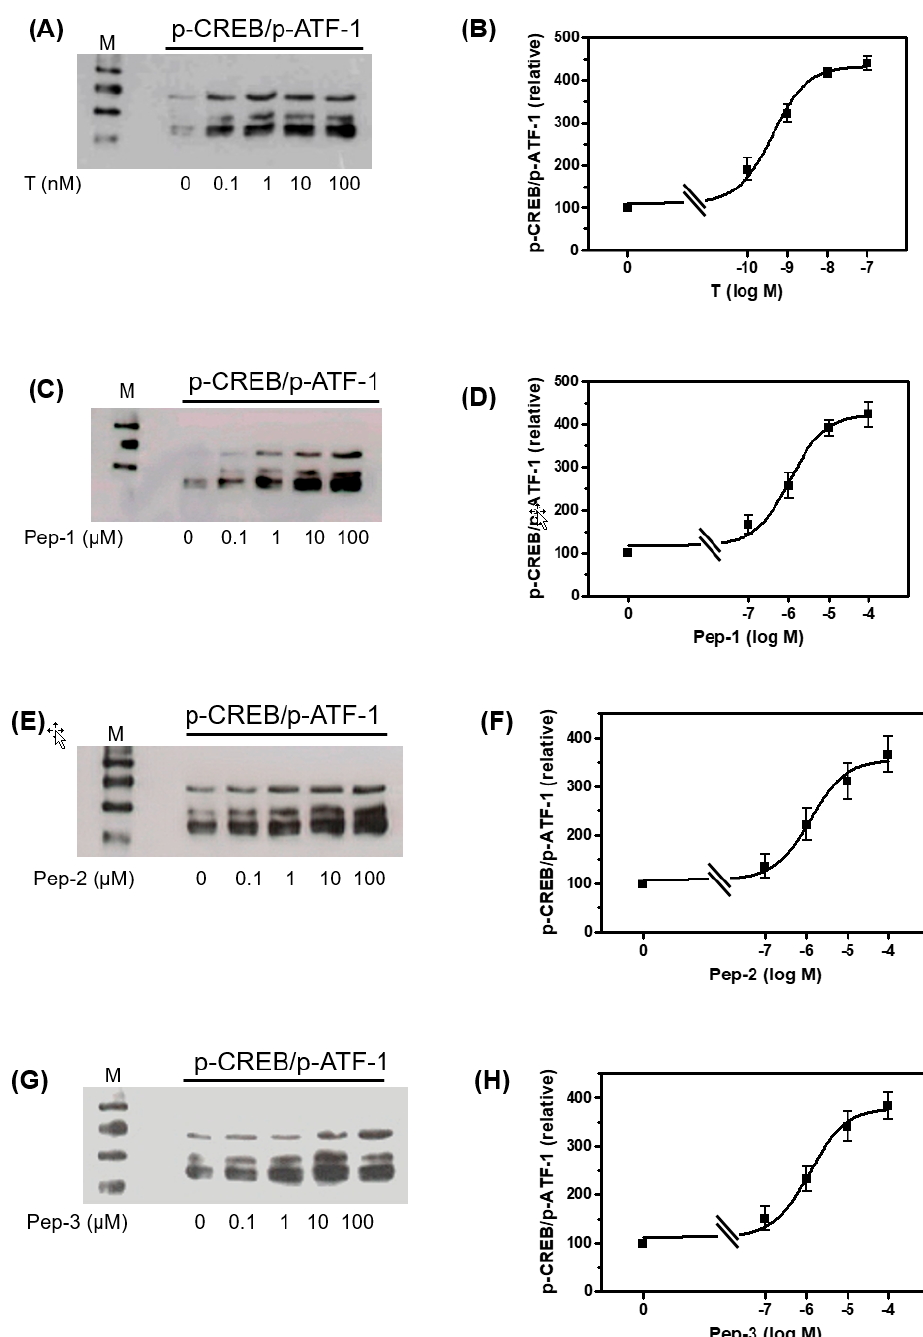
Figure 5. Western blot of phospho-CREB and phospho-ATF-1 in Sertoli cells. The 93RS2 cells were stimulated for 30 min with various concentrations of testosterone or peptides. Phospho-CREB is represented by the band at around 45 kDa, phospho-ATF-1 by the two bands at 38 and 34 kDa. ( A , C , E , G ) p-CREB/p-ATF-1 detection after stimulation with T, Pep-1, Pep-2 or Pep-3. ( B , D , F , H ) Semi-logarithmic plots of relative p-CREB/p-ATF-1 signals reveal for T an EC 50 = 0.43 ± 1.33 nM, for Pep-1 an EC 50 = 1.09 ± 1.44 µM, for Pep-2 an EC 50 = 1.27 ± 1.79 µM and for Pep-3 an EC 50 = 1.21 ± 1.56 µM. For each diagram: n = 3; means ± SD.